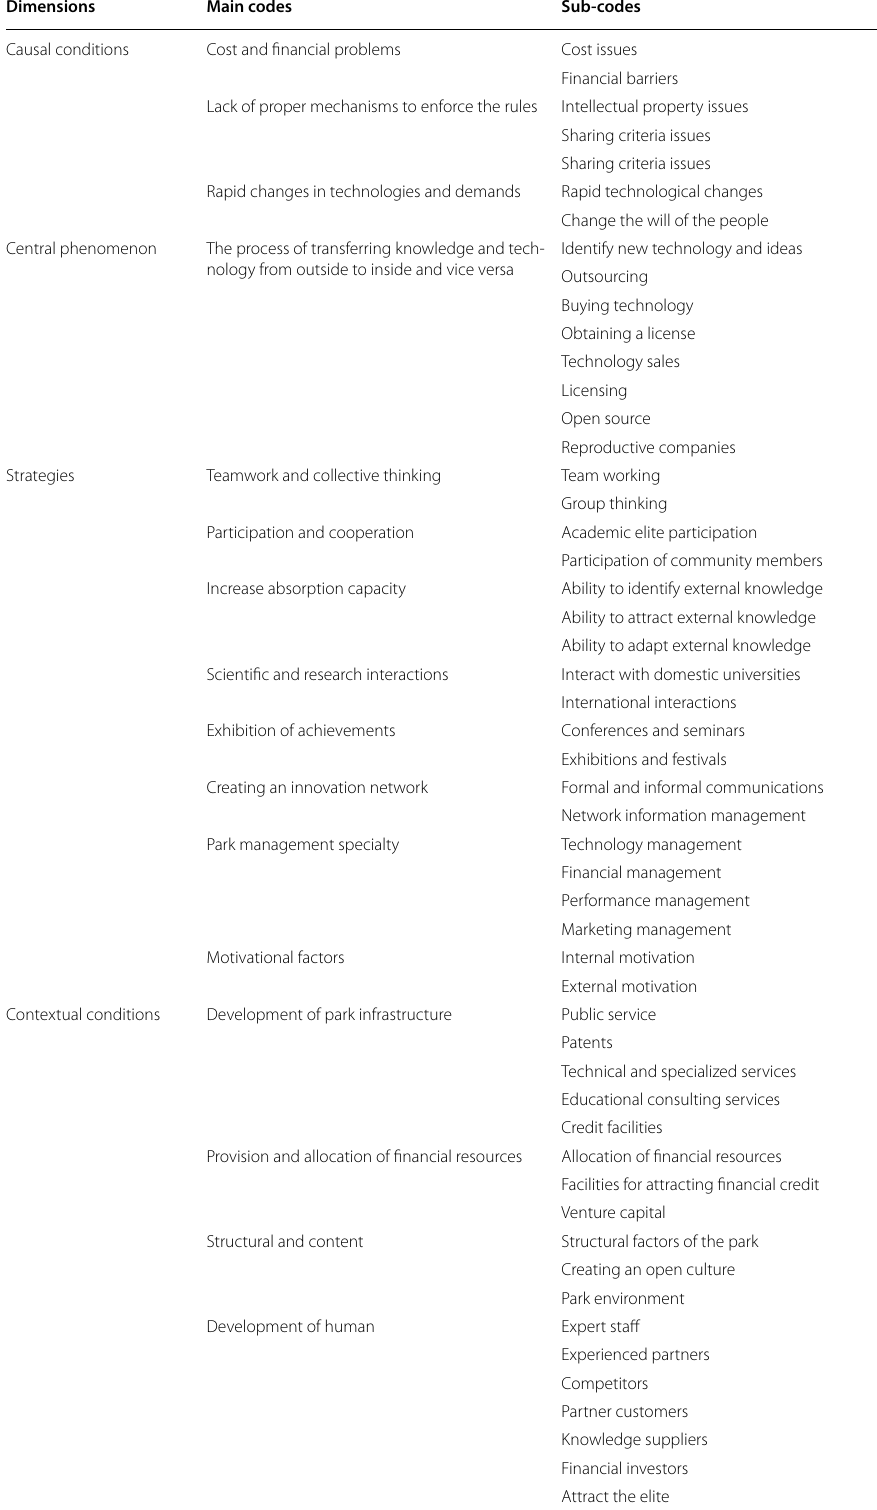
Table 1 Dimensions, main codes, and sub-codes extracted from the interviews